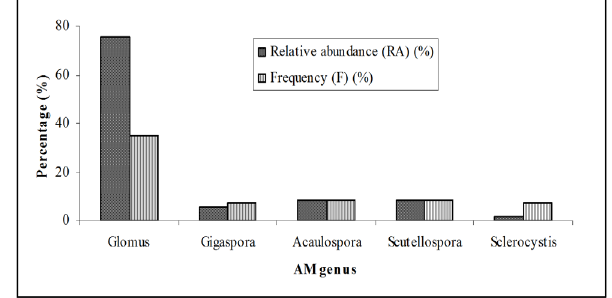
Fig. 1. Mean spore density (per 100 g dry soil) and AM root length colonization (RLC) (%) observed district wise. Mean values were calculated from the data obtained in all tehsil places belonging to particular district